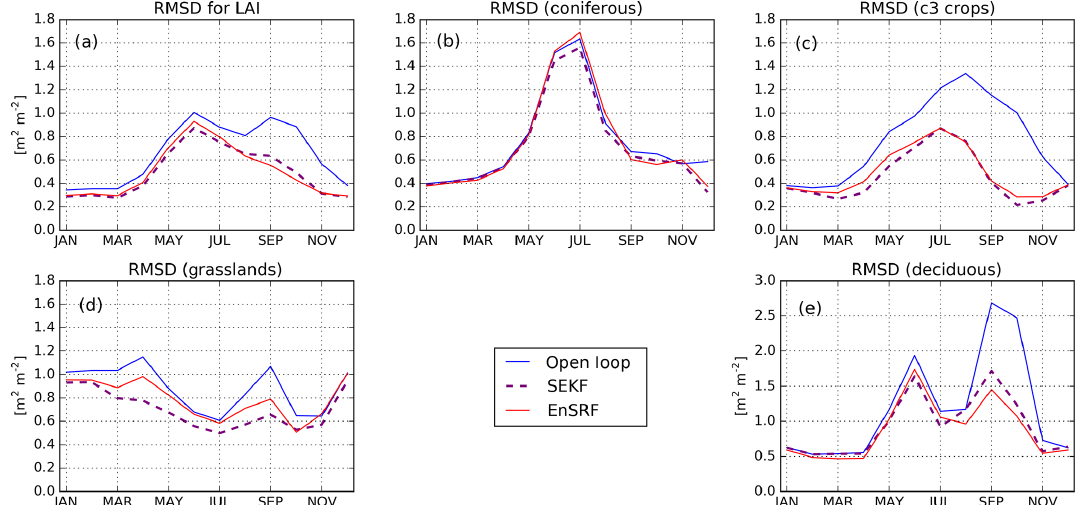
Figure 5. Seasonal RMSD between LAI from observations and the open loop (blue line), the SEKF analysis (dashed purple line) and the EnSRF analysis (red line) averaged over (a) the whole domain and grid cells where (b) coniferous trees, (c) C 3 crops, (d) grasslands and (e) deciduous broadleaved trees represent more than 50% of plants for the period 2008–2017.